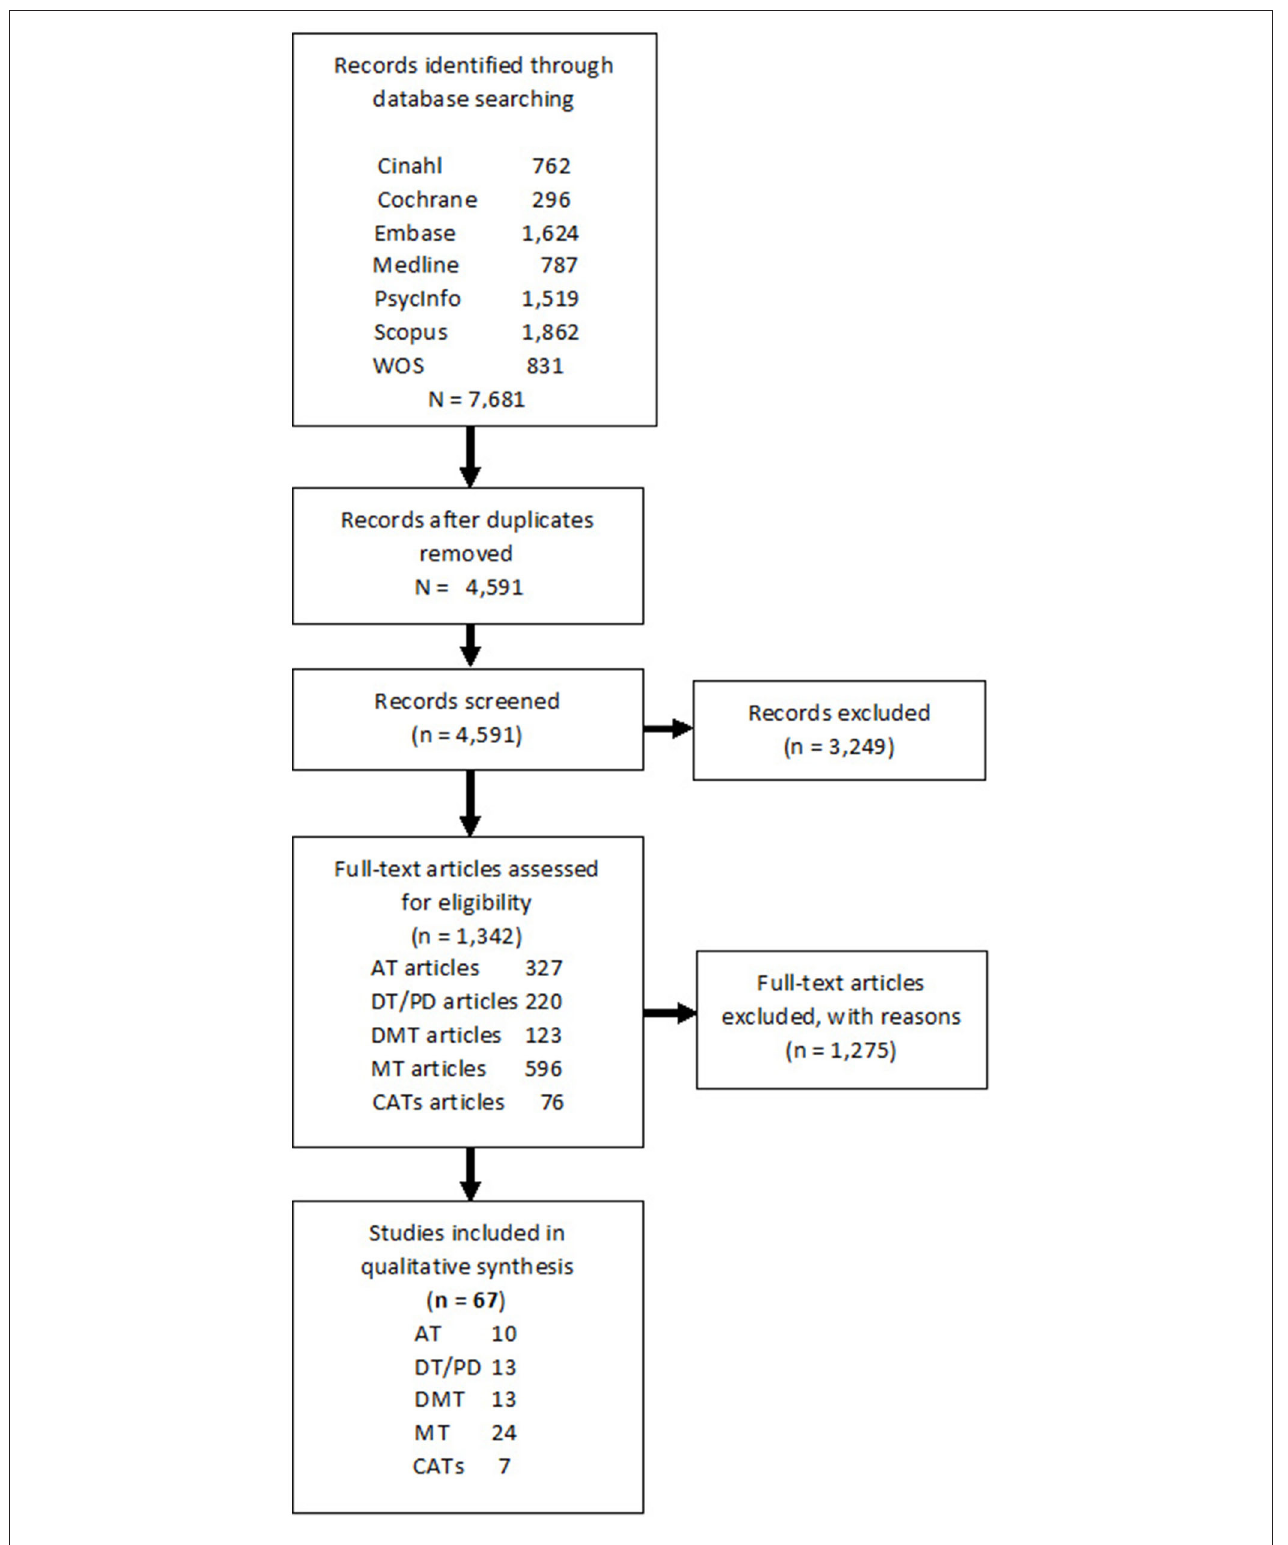
FIGURE 1 | Flow chart of the